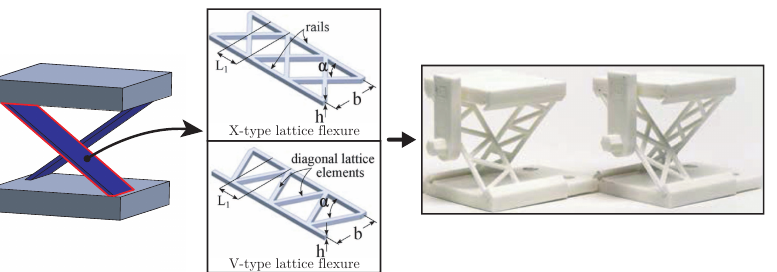
Figure 8. Lattice flexures proposed by Merriam and Howell [22] to be used in cross-axis flexural joints. (Adapted with permission from ref. [22]. 2021,